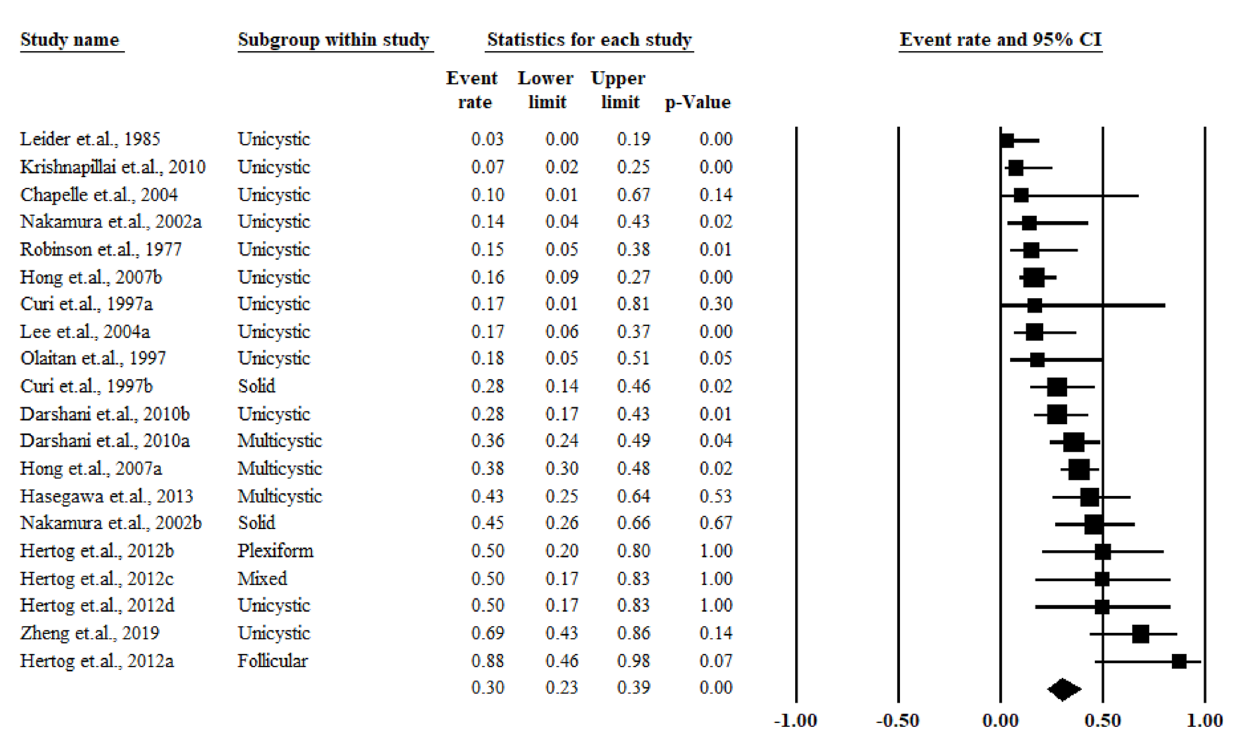
FIGURE 2 | Summary of the conservative treatment recurrence rate.